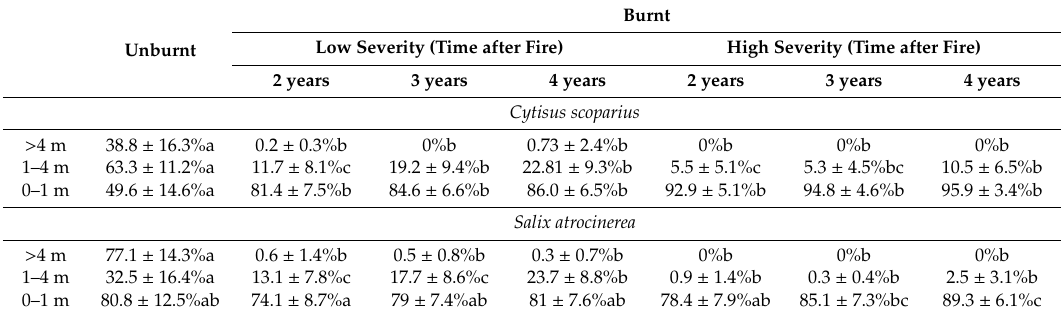
Table 1. The stratum cover (x ± sd) reached in unburnt areas and burned areas 2, 3, and 4 years after fire with di ff erent fire severity levels in the C. scoparius and S. atrocinerea communities. Burnt Low Severity (Time after Fire) High Severity (Time after Fire) Unburnt 2 years